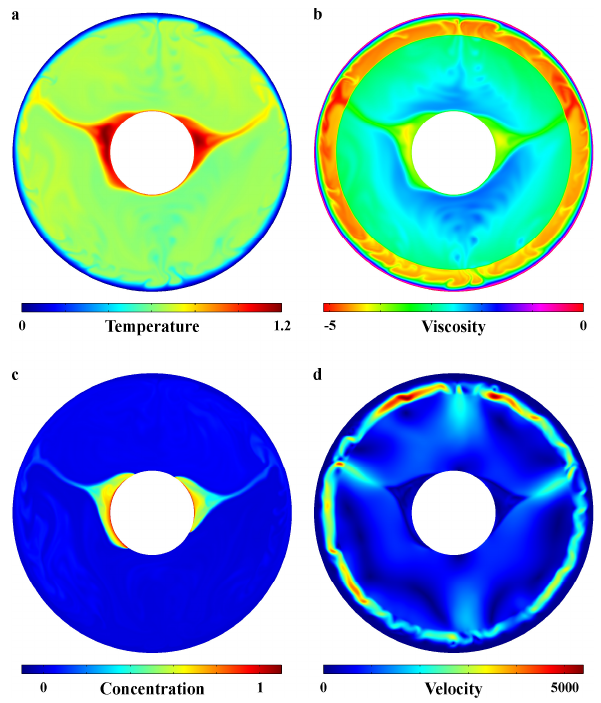
Figure 5. A quasi-stationary state of the (a) temperature, (b) vis- cosity, (c) concentration of the dense material and (d) velocity for the complex model (see text) at 3.5Gyr ( t = 0 . 01325). Viscosity is non-dimensionalized as log10( η/η S ) where η S denotes the surface